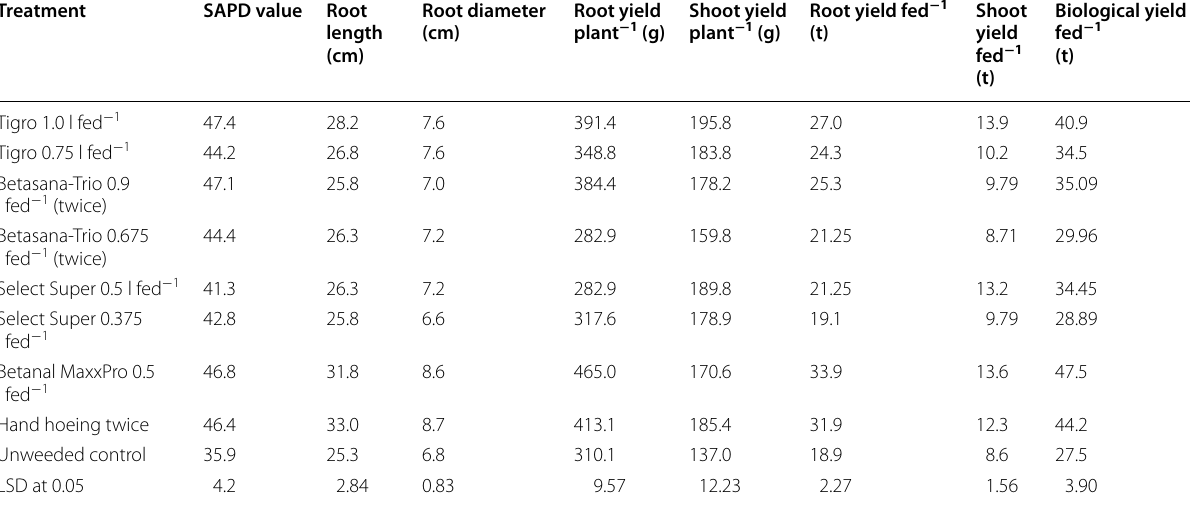
Table 4 Effect of different herbicidal treatments on sugar beet crop characteristics (combined data of 2017/2018 and 2018/2019)